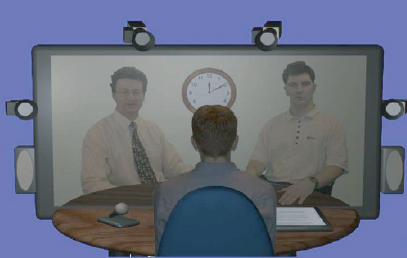
Figure 1: The mock-up of one VIRTUE station where the real ta- ble is extended seamlessly into the virtual table in display. The full- size remote participants are rendered as arbitrary 2D video objects and their synthesized looks will change in line with the local par- ticipant’s head position. The two cameras mounted on the left and top-left side of the screen provide two video streams for 3D anal- ysis and view synthesis for the left viewer in the display; likewise for the two right-hand side cameras. The eye-to-eye contact, nor- mal habitual hand gesturing, and gaze awareness are expected to be